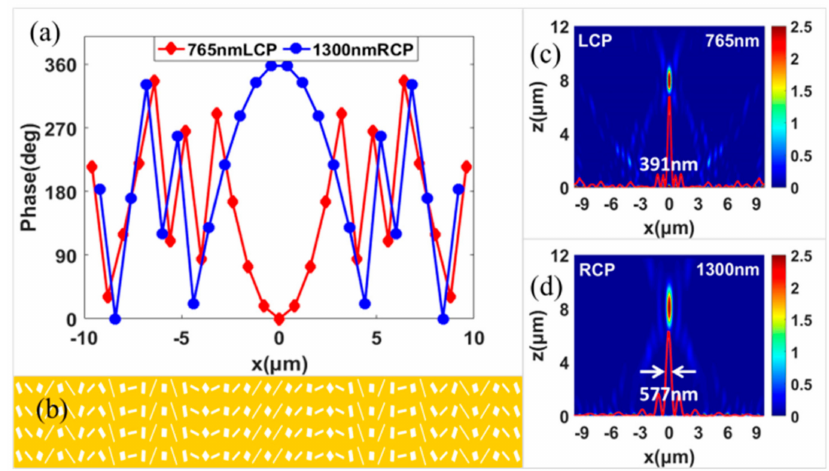
Figure 3. Phase shift distributions along x -axis ( a ) and top view ( b ) of the spin-selected dual-wavelength metalens with the same focus. Simulated intensity ( | E | 2 ) distributions in the X–Z plane of spin-selected dual-wavelength metalens under the LCP of 765 nm ( c ), RCP of 1300 nm ( d ) illuminations. The red curves show the concrete profiles of the full widths at half maximums (FWHMs) of the